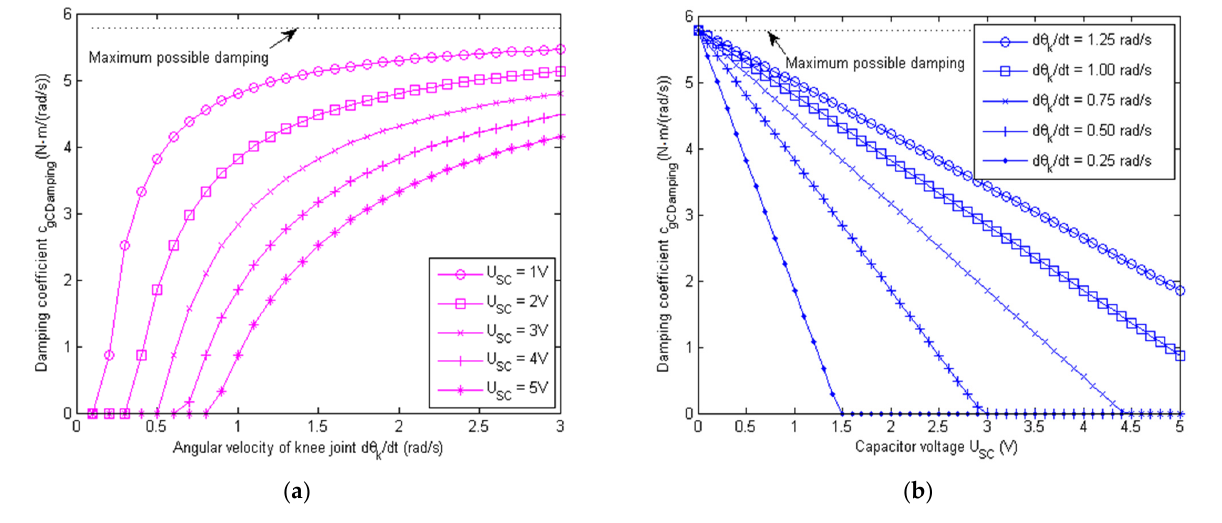
Figure 8. Modulated damping of the exoskeleton generator for capacitance load by controlling 𝑈 (cid:3020)(cid:3004) . Here, the generator armature resistance 𝑅 (cid:3028) = 6 Ω , back EMF 𝐾 (cid:3034) = 0.0442V/(rad/s) , and total transmission ratio 𝑗 (cid:3029)(cid:3030) 𝑗 (cid:3034)(cid:3029) = 133. ( a ) Simulated damping coefficient 𝑐 (cid:3034)(cid:3004)(cid:3005)(cid:3028)(cid:3040)(cid:3043)(cid:3036)(cid:3041)(cid:3034) with the capacitor load as the angular velocity of knee joint 𝜃(cid:4662) (cid:3038) changes for different super capacitor voltages 𝑈 (cid:3020)(cid:3004) .( b ) Simulated damping coefficient 𝑐 (cid:3034)(cid:3004)(cid:3005)(cid:3028)(cid:3040)(cid:3043)(cid:3036)(cid:3041)(cid:3034) with capacitor load as the super capacitor voltage 𝑈 (cid:3020)(cid:3004) changes for different angular velocities 𝜃(cid:4662) (cid:3038) of the knee joint. From Figure 8, it can be seen that the damping coefficient 𝑐 (cid:3034)(cid:3004)(cid:3005)(cid:3028)(cid:3040)(cid:3043)(cid:3036)(cid:3041)(cid:3034) with the ca- pacitor load increased with the angular velocity of the knee joint 𝜃(cid:4662) (cid:3038) . Moreover, it de- creased as the charged voltage 𝑈 (cid:3020)(cid:3004) of the super capacitor rose. Therefore, to maintain sufficient damping for the knee joint, the voltage of the super capacitor should not be too high. In this paper, a modulated damping scheme is proposed by controlling the on and off (i.e., duty cycle) nature of the MOSFET switch and load switch, which regulate the flow of the electric current 𝑖(𝜏) into the super capacitor and discharging current to